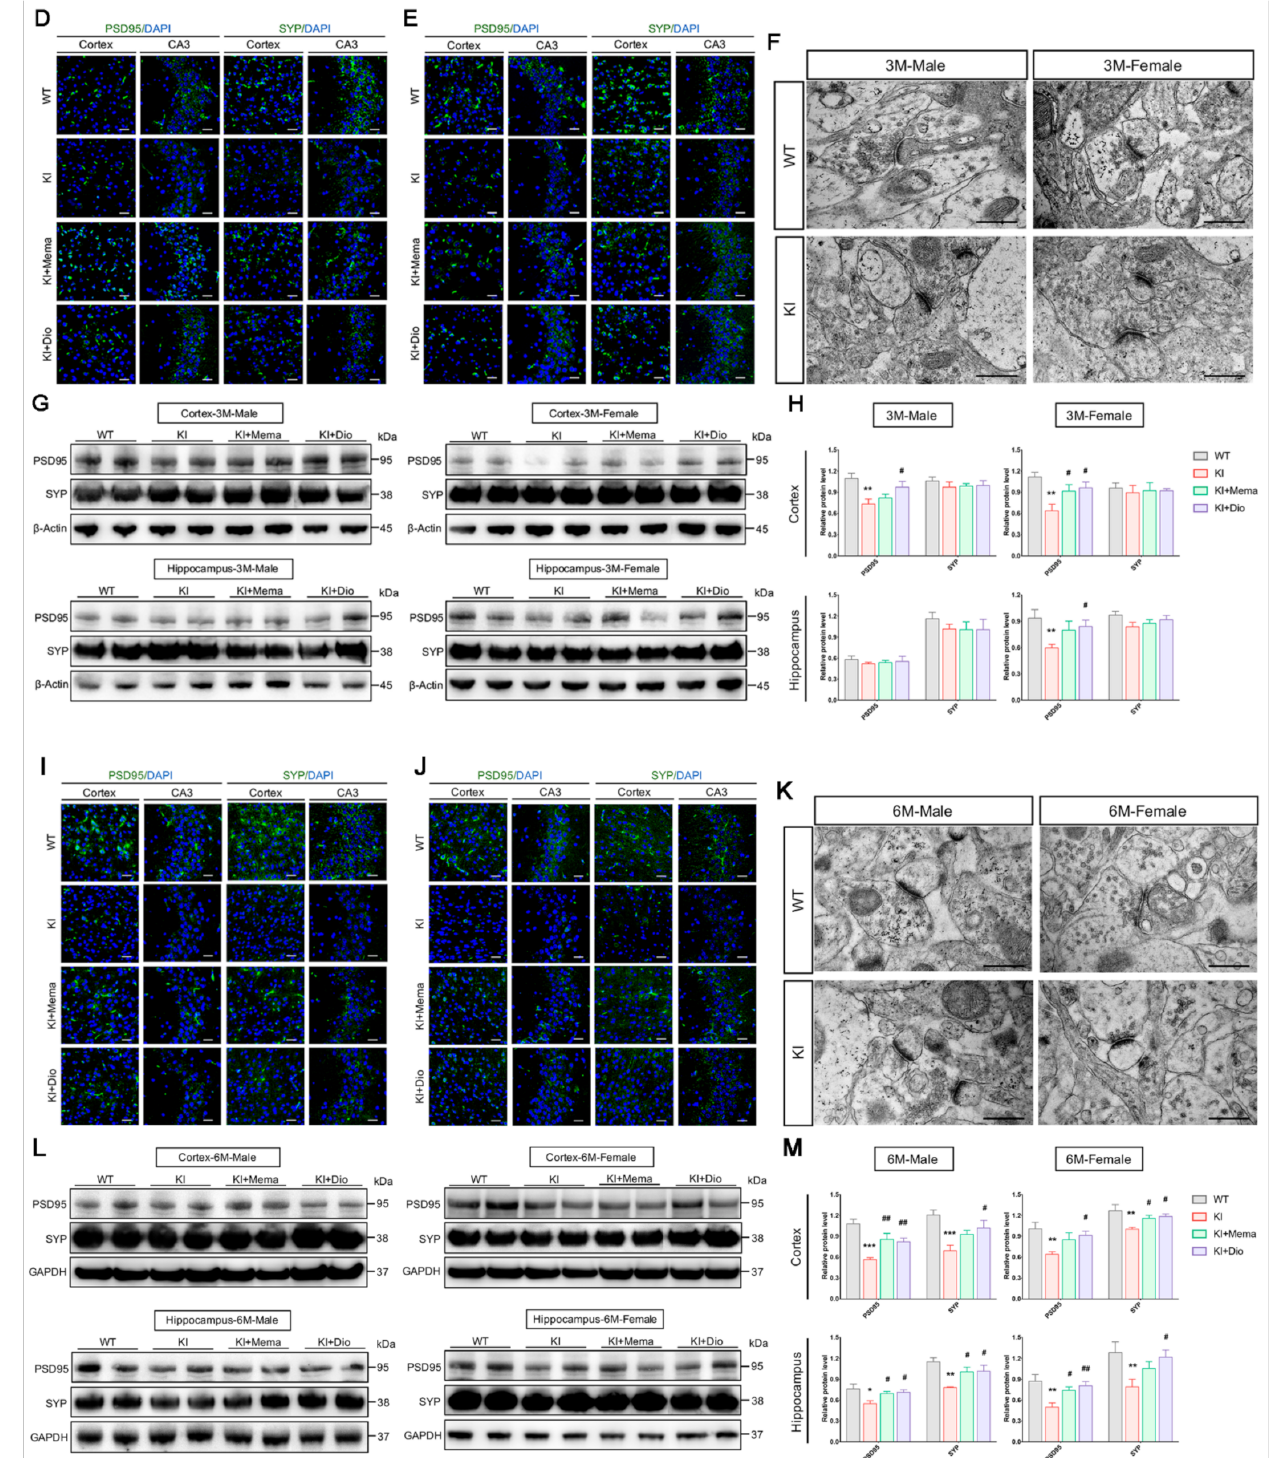
Figure 3. Effect of Dio on synaptic loss in young App NL-G-F mice. ( A – C ) Representative Golgi-staining and quantification showing spines of 3- and 6-month-old male and female WT and App NL-G-F mice. Scale bar: 0.1 mm. Data are expressed as mean ± SEM ( n = 8). * p < 0.05 compared with WT; ** p < 0.01 compared with WT. # p < 0.05 compared with App NL-G-F ; ( F , K ) TEM image from male and female WT and App NL-G-F mice showing synapses. Scale bar: 0.5 µ m; ( F ) 3-month-old male and female mice; ( K ) 6-month-old male and female mice. ( D , E , I , J ) Immunofluorescence staining of PSD95 and SYP in the cortex and hippocampus in 3- and 6-month-old male and female WT and App NL-G-F mice. Scale bar: 0.1 mm; ( D ) 3-month-old